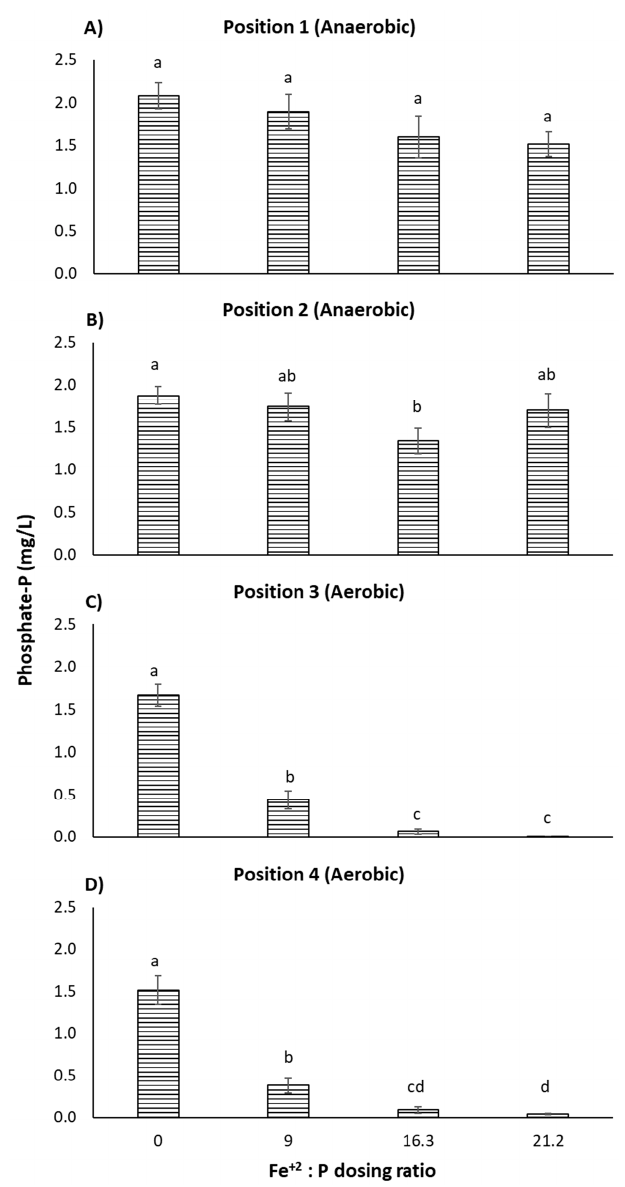
Figure 2. Phosphate concentrations relative to position within the treatment-train and FeSO 4 dosing rate. Different letters indicate differences amongst different Fe 2+ :P dosing ratios relative to positions as indicated by ANOVA with LSD Means calculations ( P = 0.05).